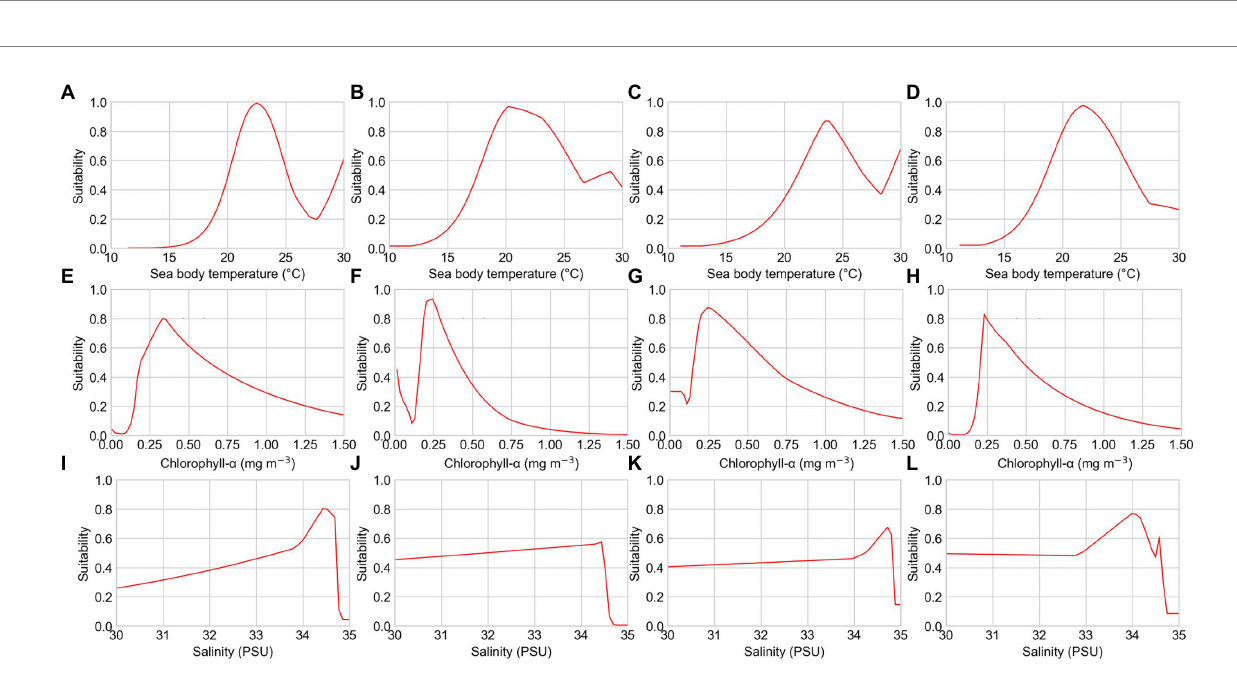
FIGURE 3 Response curves of several environmental factors affecting the distribution of reef-associated fish from the seasonal pattern simulation. (A–D) Sea body temperatures of S1, S2, S3, and S4; (E–H) chlorophyll- α concentration of S1, S2, S3, and S4; and (I–L) seawater salinity of S1, S2, S3, and S4. PSU, practical salinity